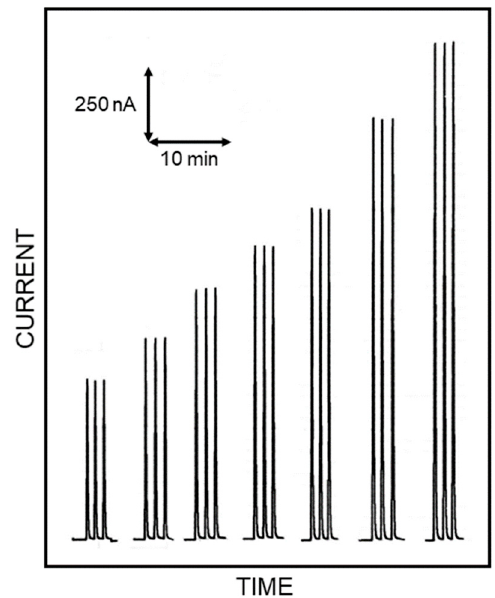
Figure 2. Typical flow injection peaks at a Pt / LO biosensor due to triplicate injections of L-lysine standard solutions at levels of (left to right) 1, 1.25, 1.5, 1.75, 2, 2.5 and 3 mM. Carrier stream: pH 5, flow rate 1 mL min − 1 . Other experimental conditions are described in the Materials and Methods section.